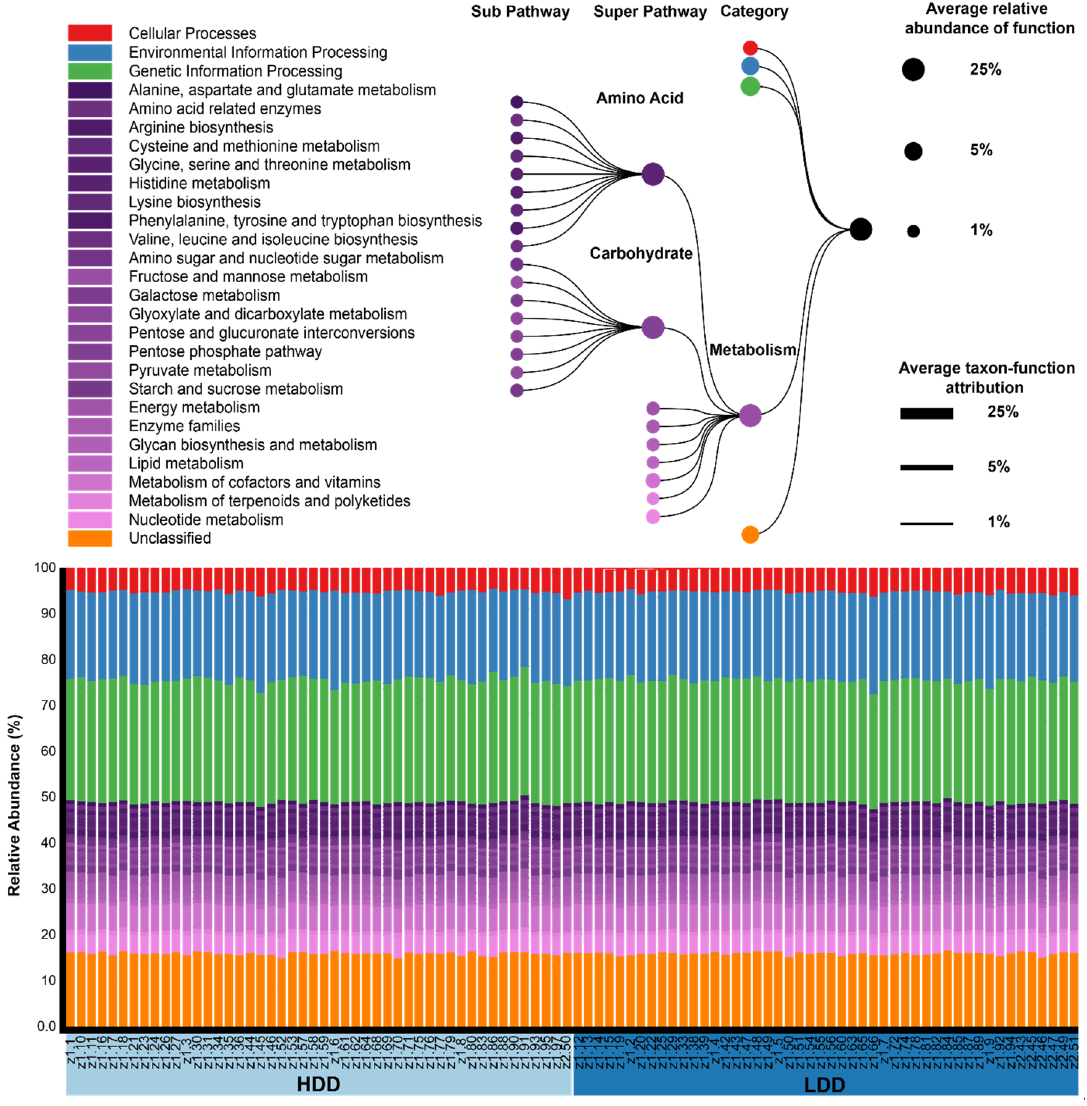
Figure 4. This figure depicts KEGG metabolism pathways obtained from PICRUSt and visualized with BURRITO. We highlighted the metabolism category and amino acid and carbohydrate super pathways. We found no significant differences in metabolic-related pathways ( p FDR > 0.10).